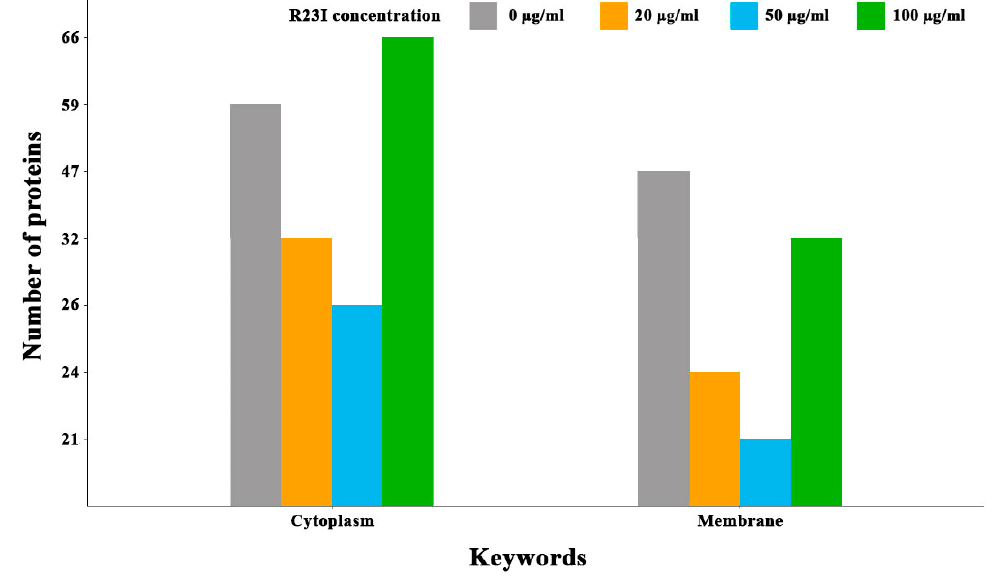
Figure 8. Number of annotated cytoplasmic and membrane proteins depending on the R23I concentration in the cellular environment.